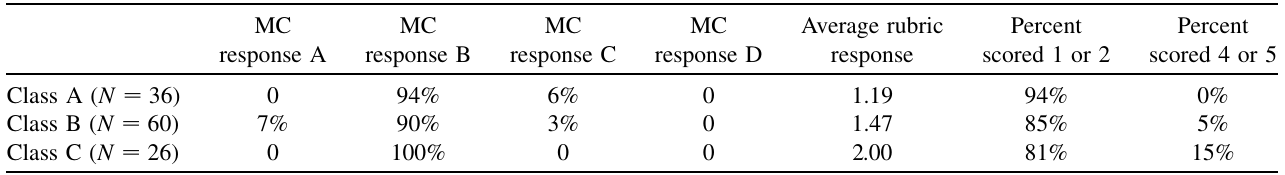
TABLE II. Pretest data for percentage of preservice immersion participants’ answers for each possible response to question in Fig. 1 and rubric scores for class. (MC refers to multiple choice.)